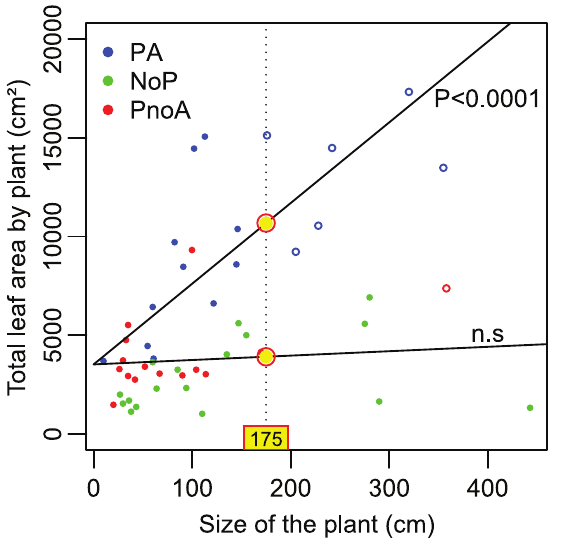
Figure 2. Growth improvement conferred by Camponotus schmitzi to its host-plant Nepenthesbicalcarata . While the total leaf area increased linearly with plant size for plants occupied by C. schmitzi (in blue), this was not the case for unoccupied plants. A common non- significant regression line was estimated for pitcher-bearing (green) and pitcher-lacking (red) unoccupied plants. Filled points are plants which